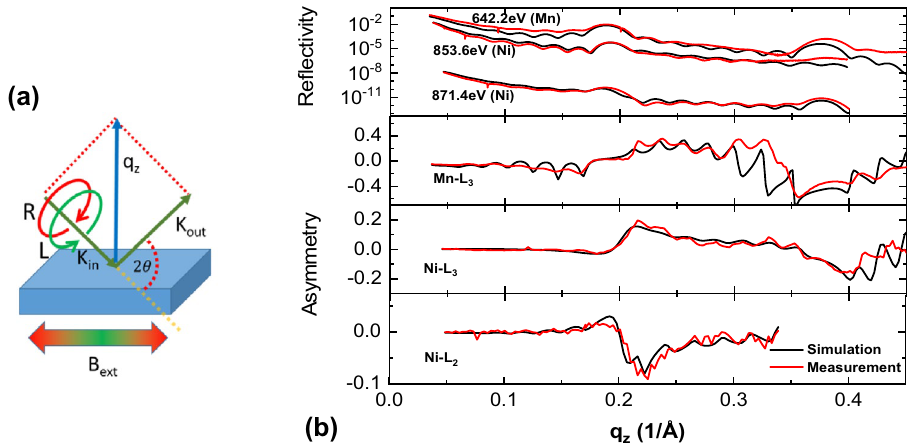
Figure 4. ( a ) Experimental θ–2θ geometry, showing the incoming and outgoing photon K vector of circular polarized light, where the magnetization has been flipped in plane. q Z is the vector for the momentum transfer. ( b ) Fitted reflectivity and asymmetry curves the normed asymmetry is the difference between for reflectivity curves measured for left and right circular light on the